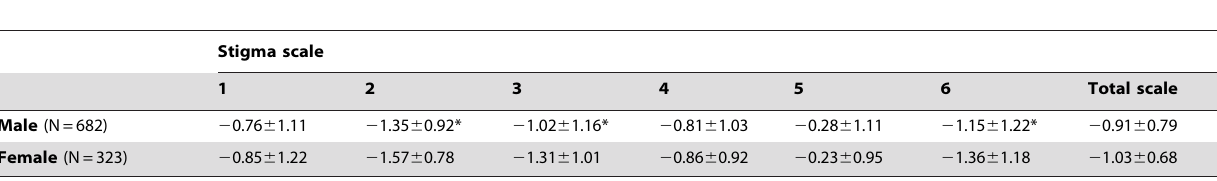
Table 6. Stigma scores (M 6 SD) on the subscales and total scale of the questionnaire for male and female respondents